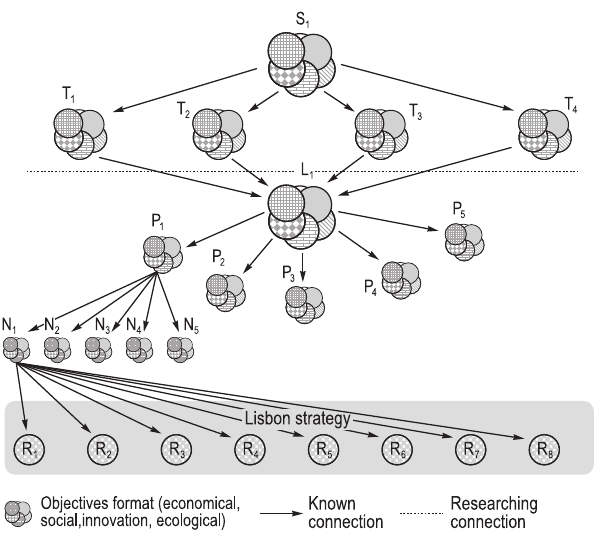
Fig 1. Structure of “molecule” of development objectives and relations with progress indexes of Lisbon strategy: S – goal 1 of EU regional policy, T , ..., T – objectives of EU structural 1 4 funds, L – goal of Single Programming Document (SPD) 1 for Lithuania for 2004–2006, P , ..., P – objectives of SPD 1 5 fi nancing strategies (priorities), N , ..., N – objectives of 1 5 measures for separate priority, R , ..., R – progress 1 8